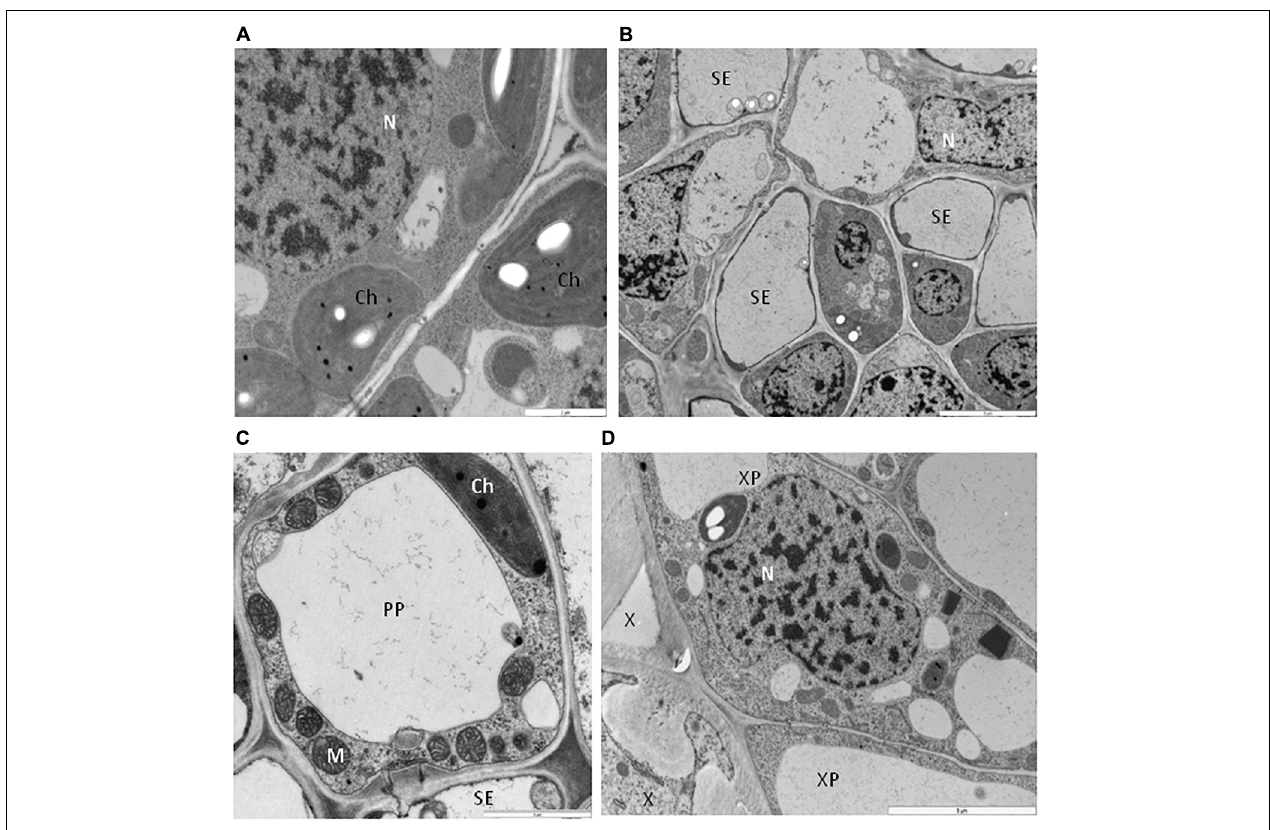
FIGURE 3 | Cells of bell pepper tissues free of BPEV. (A) Spongy mesophyll cells. Ch-chloroplast, N-nucleus. Bar 2 µ m. (B) Phloem cells. N-nucleus, SE-sieve element. Bar 5 µ m. (C) Sieve element (SE) with companion cell (CC). Ch-chloroplast, M-mitochondria. Bar 5 µ m. (D) Xylem cells. N-nucleus, X-xylem tracheary elements, XP-xylem parenchyma. Bar 5 µ